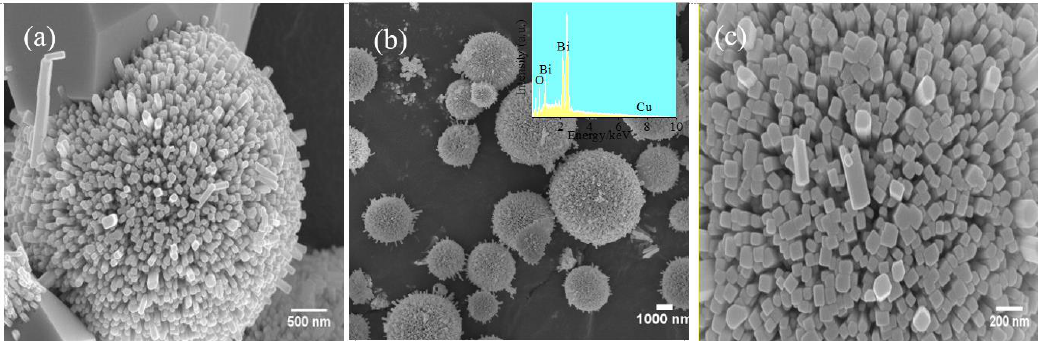
Figure 1. Scanning electron microscopy (SEM) images of as-prepared ( a ) CuBi 2 O 4 and ( b , c ) CuBi 2 O 4 -OVs; the inset is the energy dispersive spectroscopy (EDS) spectra of CuBi 2 O 4 -OVs.